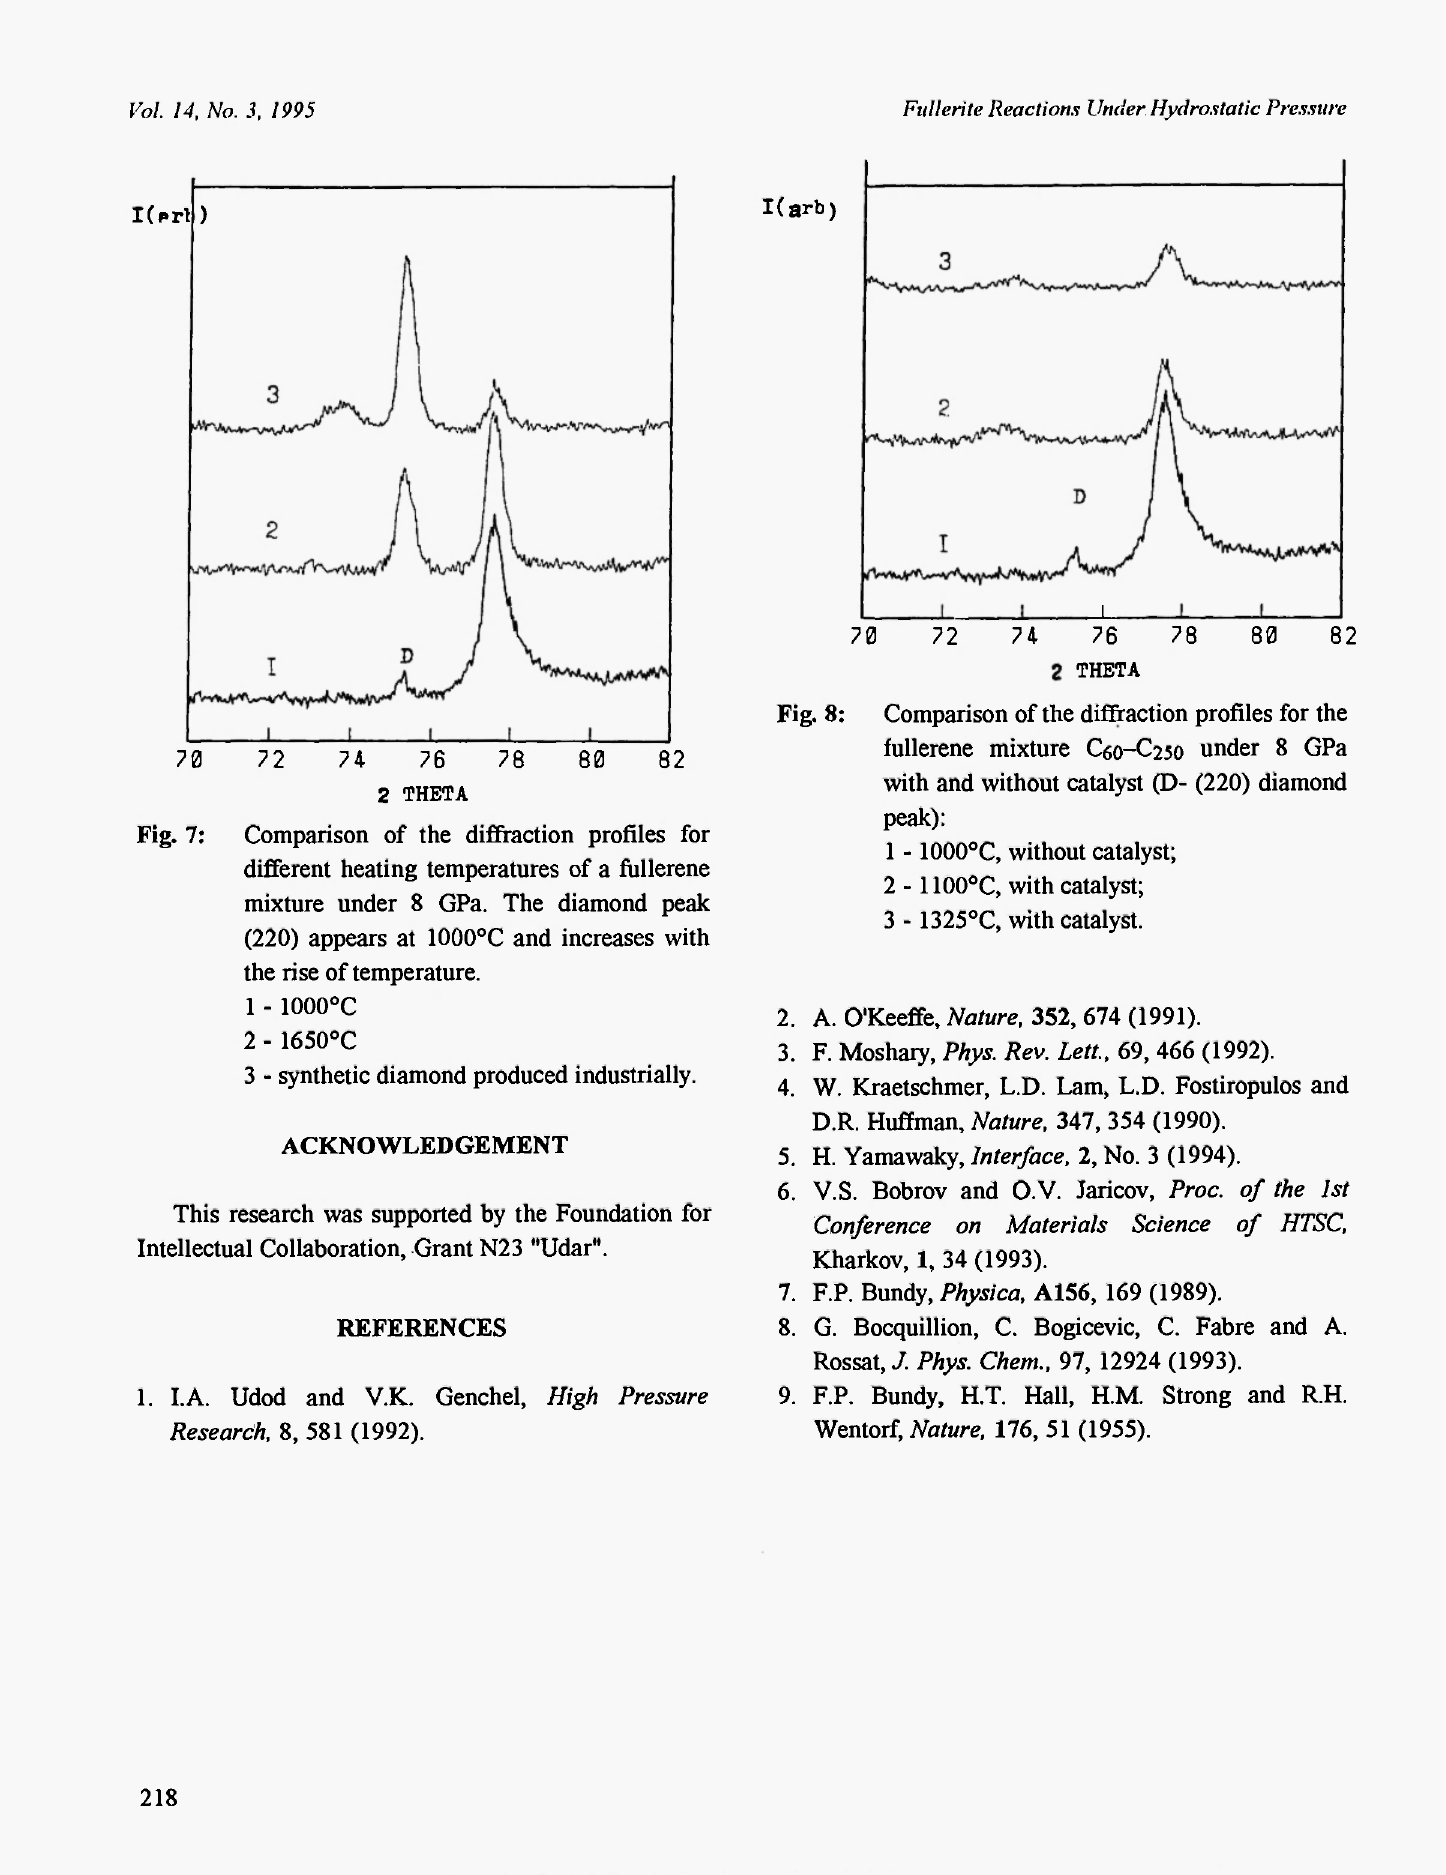
72 78 76 2 THETA Comparison of the diffraction profiles for Fig. 7: different heating temperatures of a fullerene mixture under 8 GPa. The diamond peak (220) appears at 1000°C and increases with the rise of temperature. 1 - 1000°C